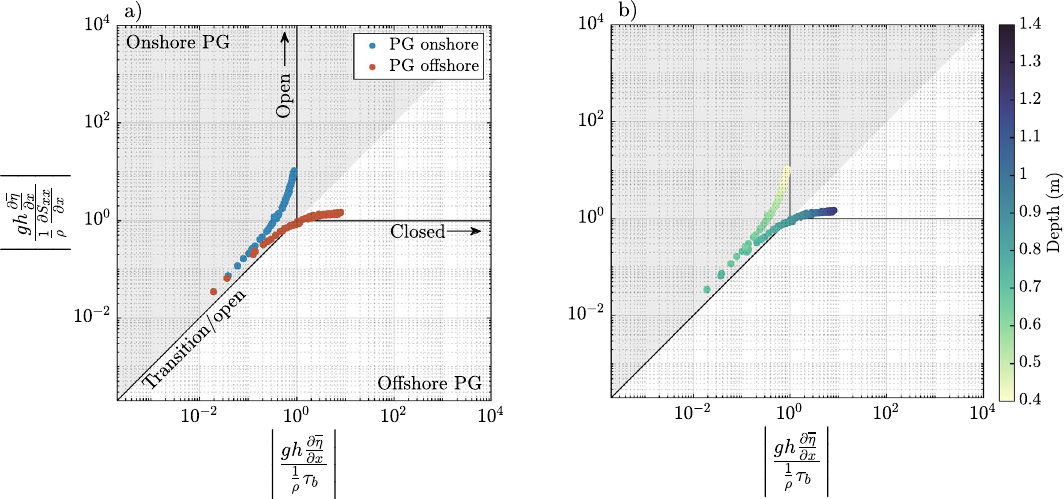
Figure 8. Momentum phase diagrams for the C D = 0.01 simulation. Momentum terms are evaluated over a tidal period at the location indicated in Fig. 2a on the reef flat. ( a ) Markers are colored according to the direction of the pressure gradient, i.e. an onshore (offshore) pressure gradient force is blue (red). ( b ) Markers are colored according to depth on the reef flat.